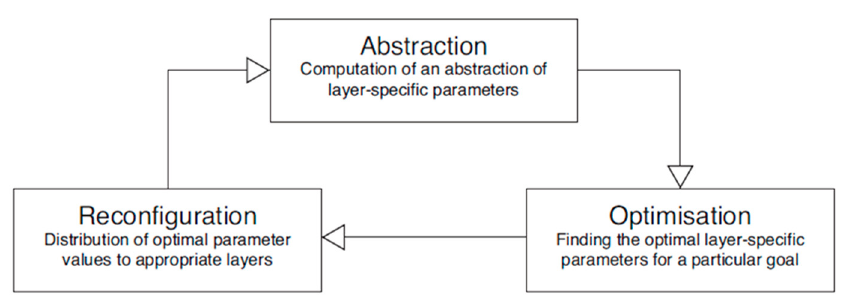
Figure 4. The stages of cross-layer interaction [191].